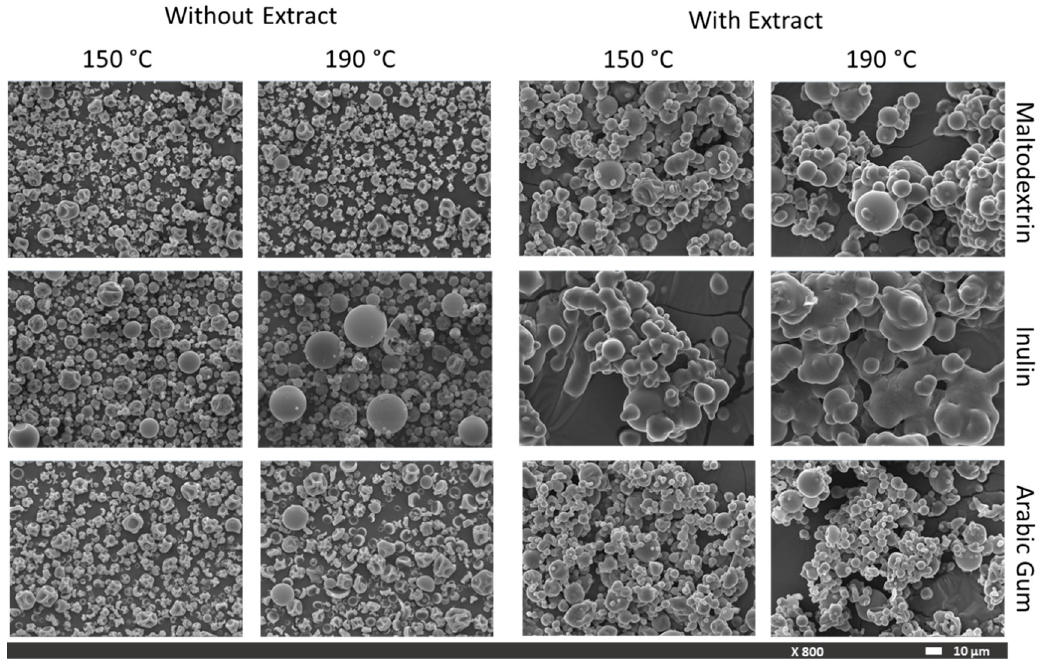
Figure 1. Scanning Electron Microscopy (SEM) images of particles obtained with different wall materials and drying temperatures, with and without extract.